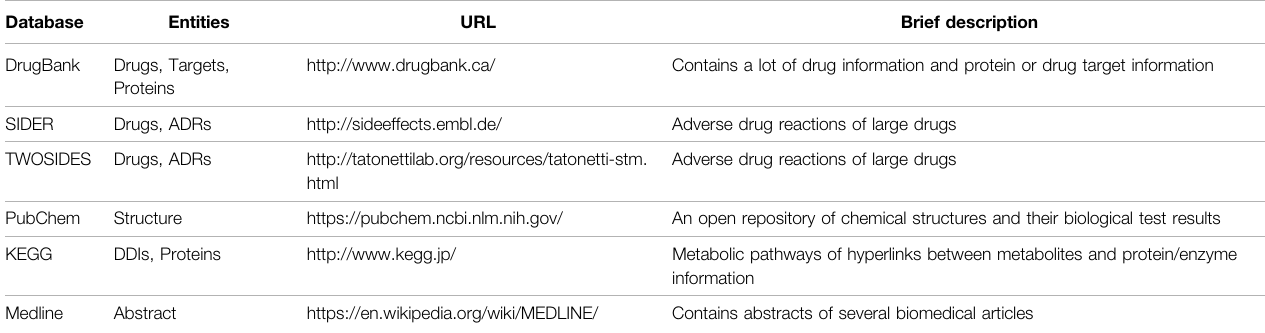
TABLE 2 | Common database used to predict drug